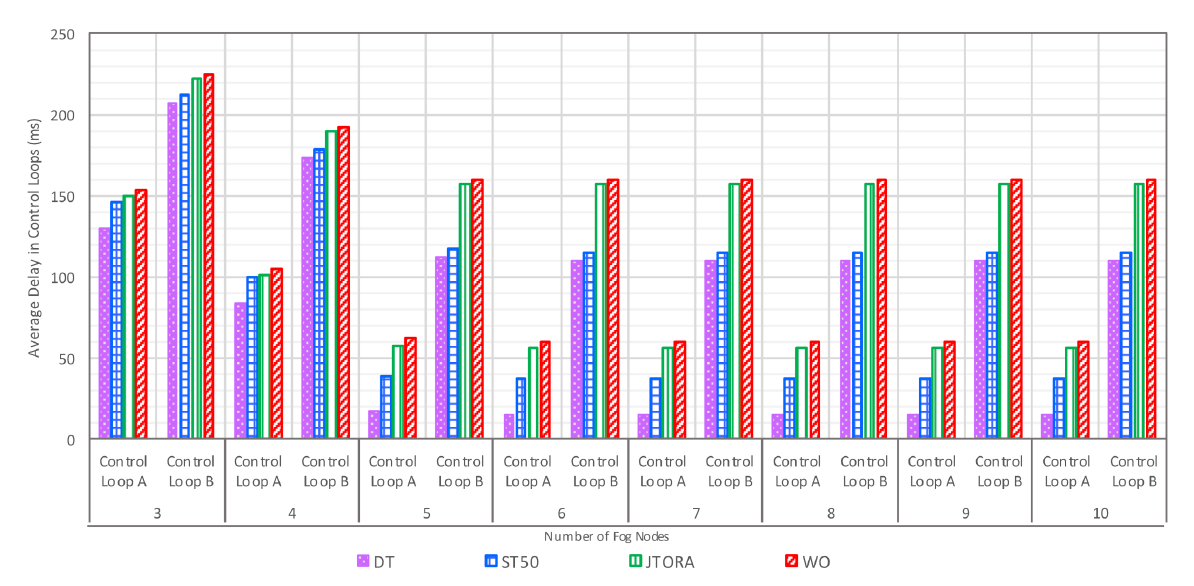
Figure 8. Impact of Increasing Number of Neighbors on Average Delay in Control Loops with Various Offloading